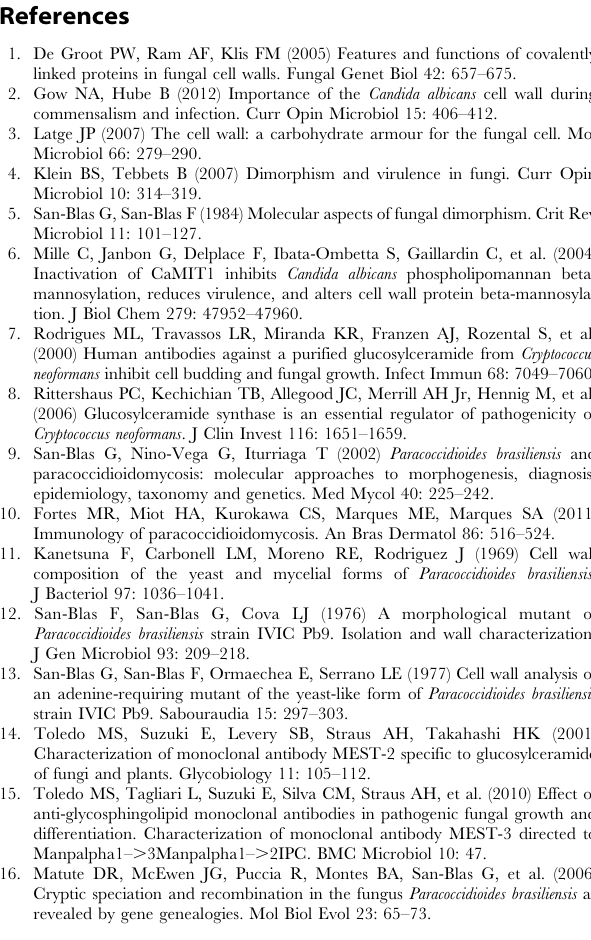
mapping using pulsed-Q dissociation (PQD) and spectra were analyzed manually. Assigned peaks are indicated. (PPTX) Figure S10 Tandem-MS spectrum of the glycolipid Hex- C18:0-OH/d18:1-Cer identified at m/z 864.9. Fragmen- tation was performed in the positive-ion mode by TIM using PQD and spectra were analyzed manually. Assigned peaks are indicated. (PPTX) Figure S11 Tandem-MS spectrum of the glycolipid Hex- C18:1-OH/d19:2-Cer identified at m/z 874.9. Fragmen- tation was performed in the positive-ion mode by total-ion mapping using PQD and spectra were analyzed manually. Assigned peaks are